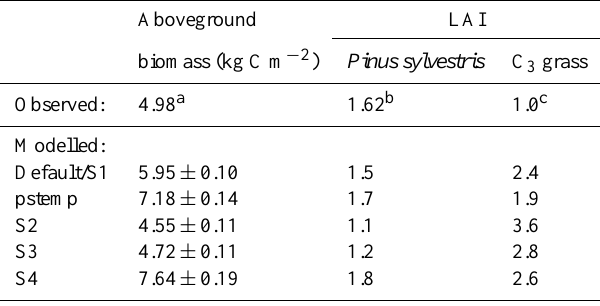
a 9.23 kgm − 2 standing biomass in 1997, annual growth increment of 0.124 kgm − 2 (data source: http://www.climatexchange.nl/sites/loobos/). To convert to carbon mass a factor of 0.5 was used (e.g. see Sandström et al., 2007; Thomas and Martin, 2012), resulting in an estimated average aboveground biomass between 1997 and 2009 of 4.98kgCm − 2 . b Measured average tree LAI from 1997 to 2009 (unpublished data), minimum 1.44 (2007), maximum 1.78 (2009), standard deviation is 0.10. Dolman et al. (2002) report maximum LAI of 1.9 for 1997. c Measurements between 1999 and 2002 ( n = 52), standard deviation 0.4 m 2 m − 2 (unpublished data).